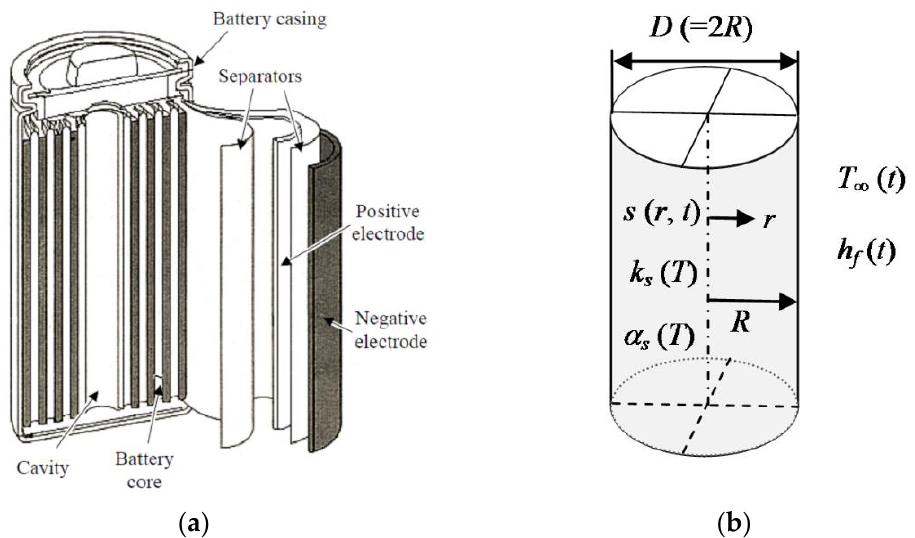
Figure 7. ( a ) A typical configuration of the spiral and multilayer structure of a standard cylindrical cell [6] and ( b ) the realistic prediction of cell temperature depends on the actual description of the time-dependent thermal boundary conditions. Reprinted with permission from [38]. Copyright 2013 Elsevier.